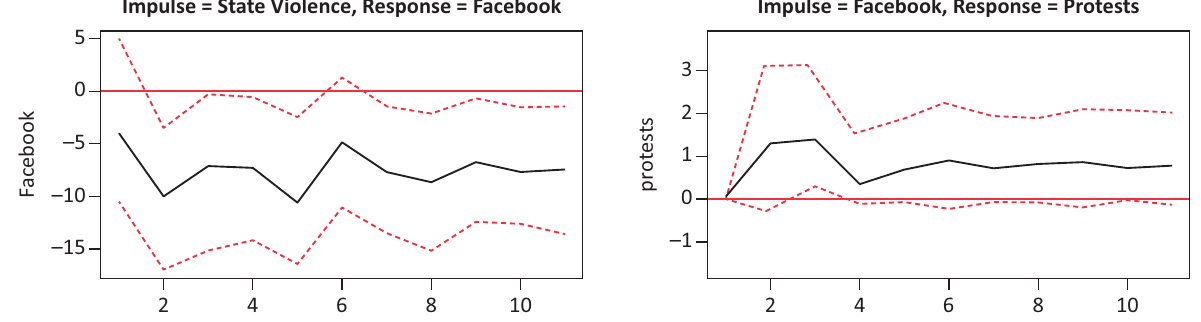
Figure 4. Impulse response function about Facebook activity, Myanmar. on disinformation about the development of the OPM, Chinese disinformation highlighted specific claims of violence to motivate disapproval of the Hong Kong protests. Focusing more on election fraud claims, the Tatmadaw repeatedly brought up democratic principles, but framed themselves as pro‐democracy and the NLD as anti‐democratic.